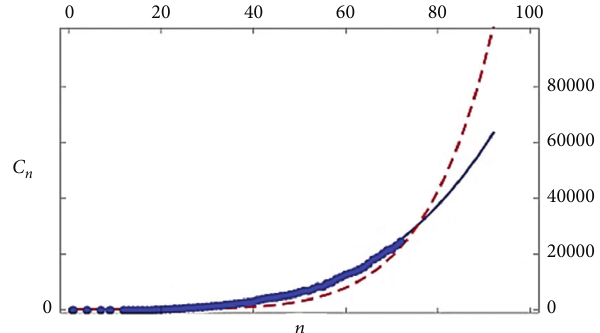
Figure 1: Epidemic confirmed C